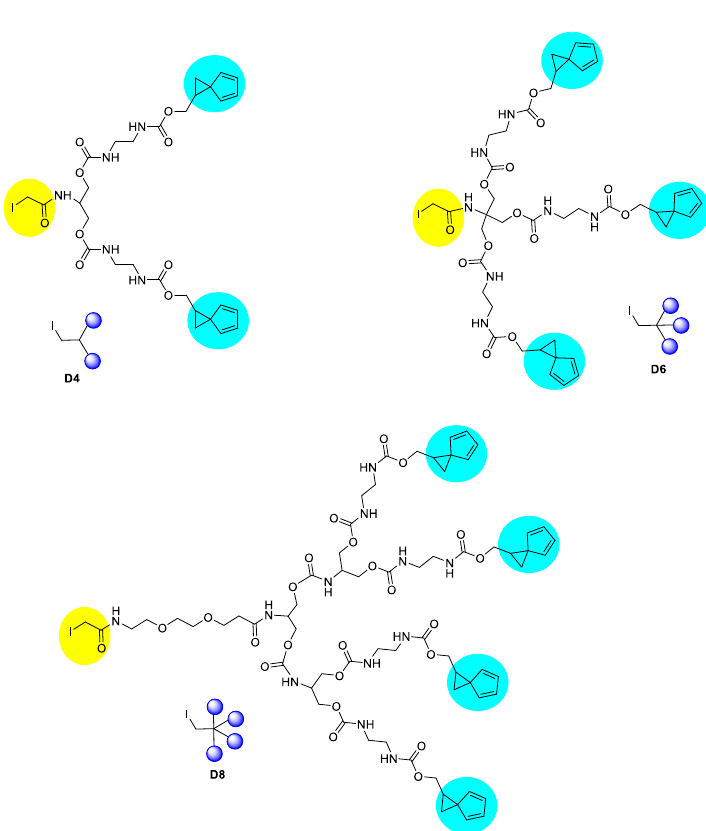
Figure 2. Design of the branched linkers used for preparing high-DAR ADCs in a site-specific manner.